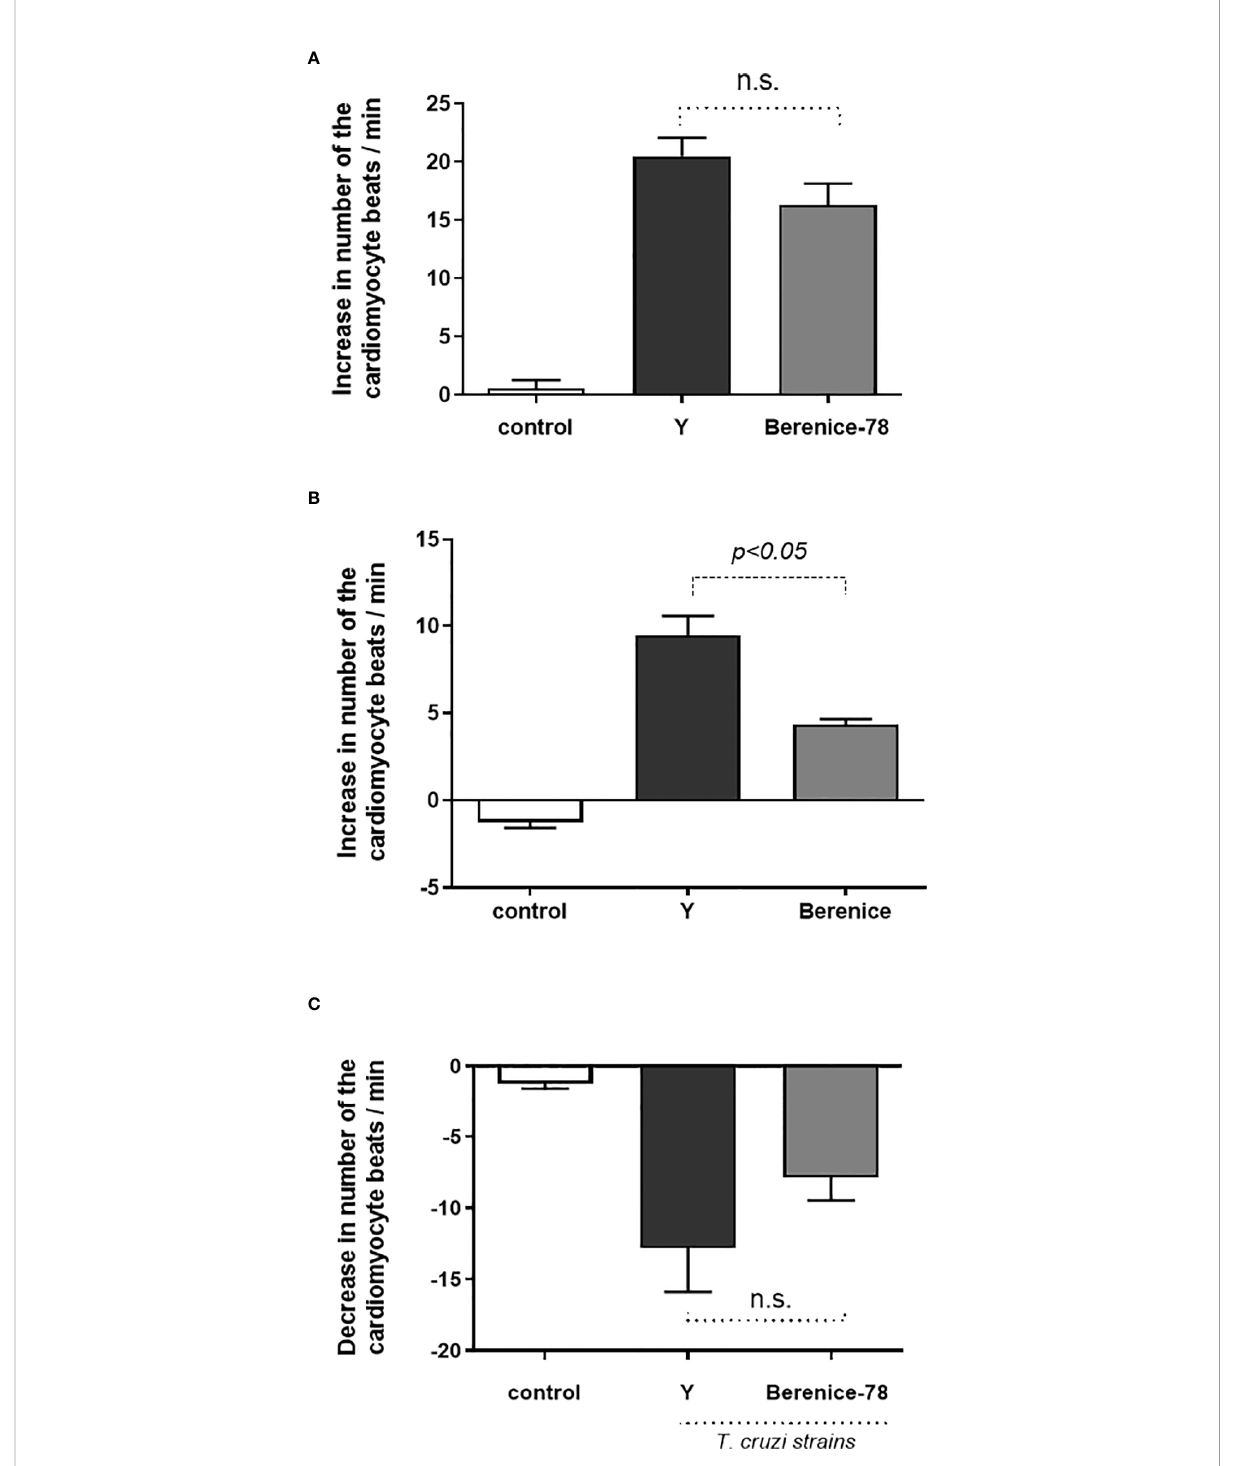
FIGURE 2 Activity of the b 1-adrenoceptor, b 2-adrenoceptor and muscarinic M2 receptor antibodies (Abs) on serum obtained from animals infected by Y and Berenice-78 T. cruzi strains and on serum from uninfected dogs (controls). In the control samples, no functional Abs against G-protein coupled receptor were identi fi ed. (A) b 1-adrenoceptor Abs activity; (B) b 2-adrenoceptor Abs activity; and (C) the negative chronotropic activity of the muscarinic M2 receptor Abs. N.S., not signi fi cant